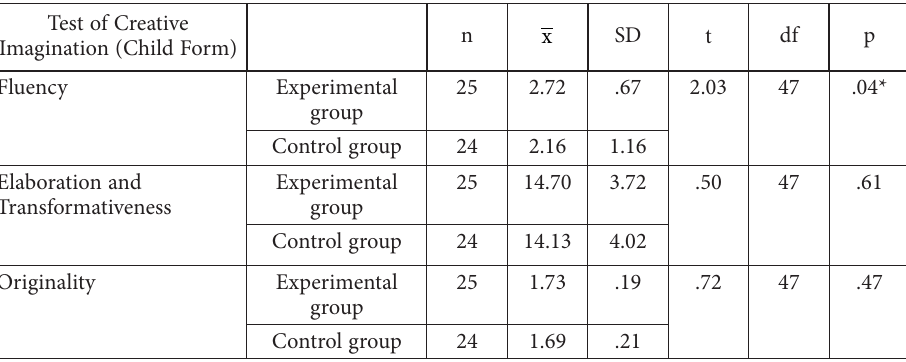
Table 3. Independent Samples T-Test results for post-test mean scores of the children in the experimen- tal and control groups (source: created by